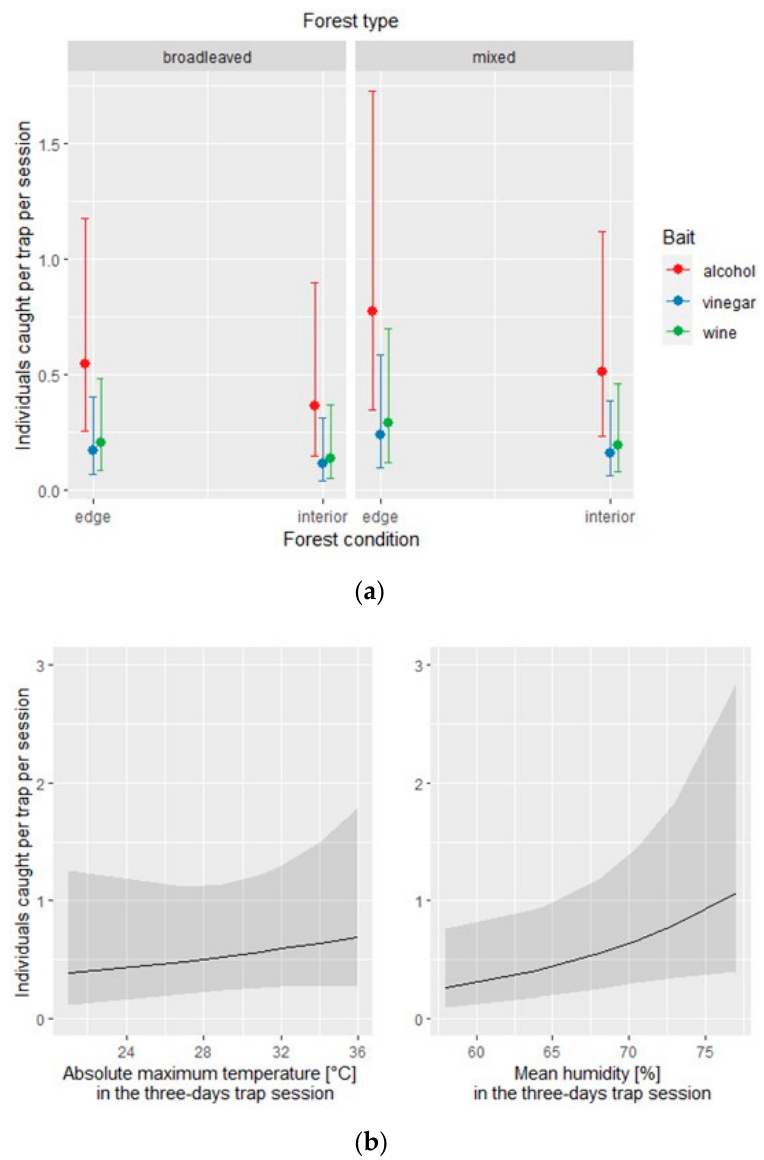
Figure 4. Native species: effect of the covariates of the negative binomial regression model affecting the number of individuals caught by each of the three traps per site and per session; ( a ) conditional effect of habitat covariates (forest type: broadleaved vs. mixed; forest condition: edge vs. interior); ( b ) main effect of meteorological covariates. Table 5. Native species. Effectiveness of baits in attracting individuals of all species pooled to- gether, accounting for the effects of habitat and meteorological covariates considered in the nega- tive binomial regression model.